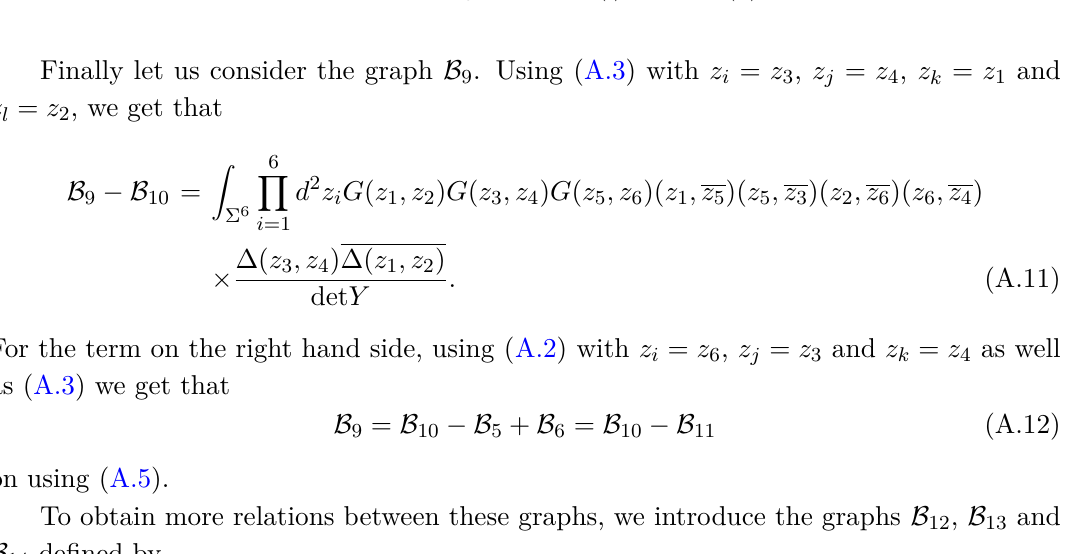
Figure 4 . The string invariants (i) B 12 and (ii) B 14